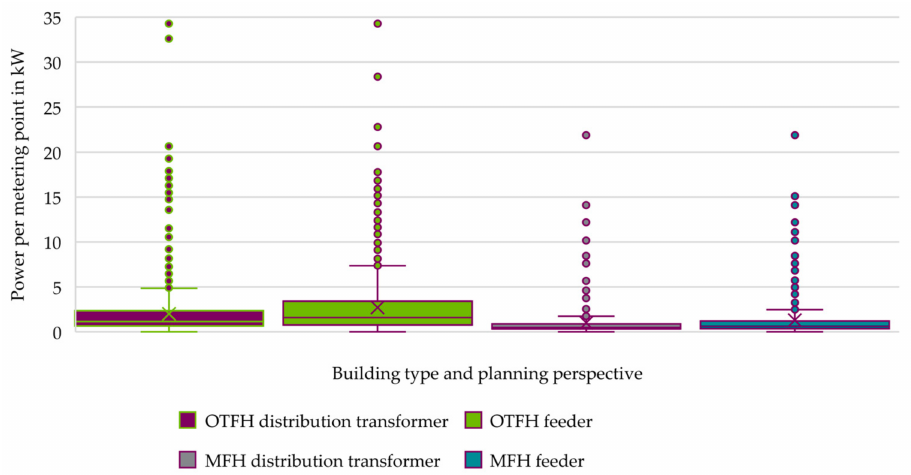
Figure 27. Distribution of conventional loads per building type and planning perspective based on [41].